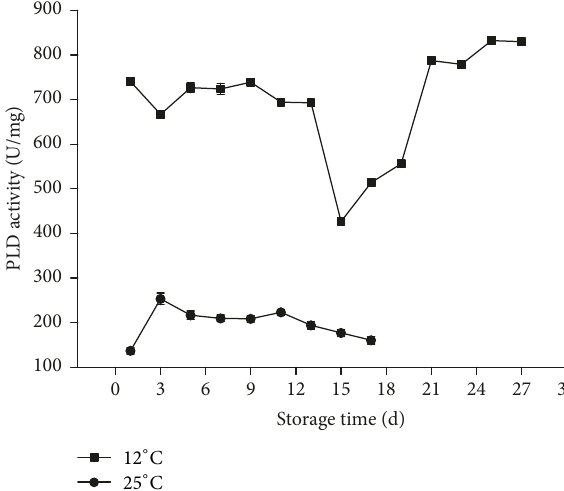
Figure 4: PLD activity stored for different periods at 25 or 12 ∘ C.